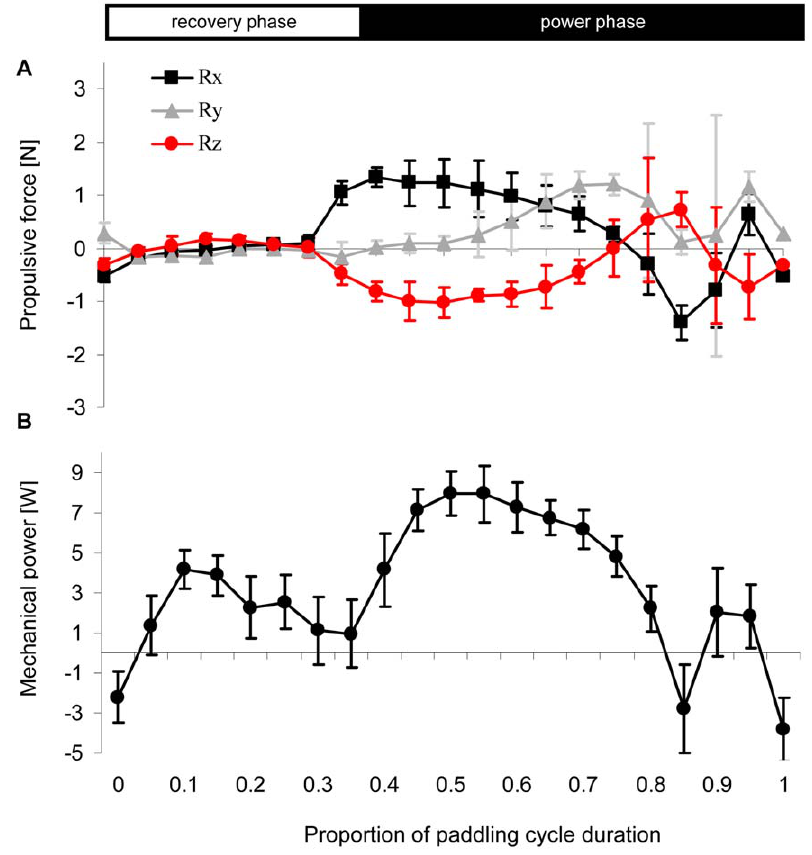
Figure 8. Hydrodynamic force and power of paddling. A) The mean x, y, z components (see Fig. 2) of the resultant propulsive force (R) for the entire left foot as estimated by the model from the foot kinematics (N=4 6 SD). Positive values refer to forward (x), left (y) and dorsal (z) in the bird’s frame of reference. B) The instantaneous mechanical power exerted for moving both feet through water during the paddling cycle (twice the power calculated for only the left foot) (N=4 6 SD). The horizontal axis is the same as in Fig. 4. The horizontal white and black rectangles at the top illustrate the division of the paddling cycle into the power and recovery phases.